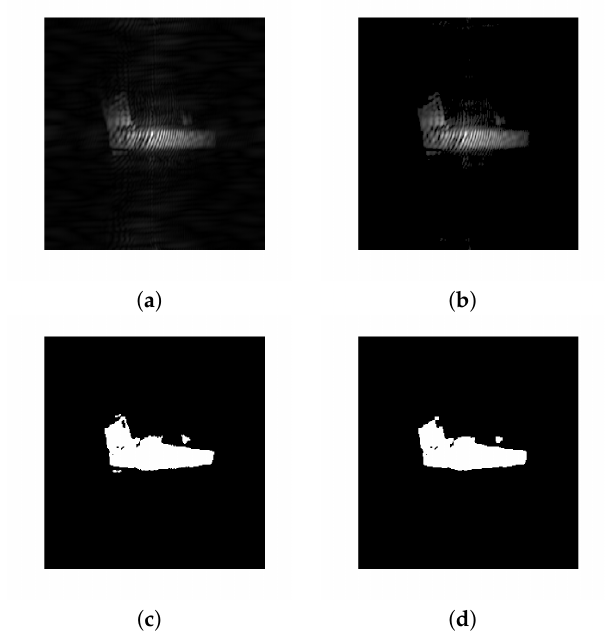
Figure 10. Illustration of the image processing chain on a concealed gun, ‘H’ polarization, 94 GHz: ( a ) grey level, ( b ) enhanced, ( c ) binarized, ( d ) mathematical morphology.